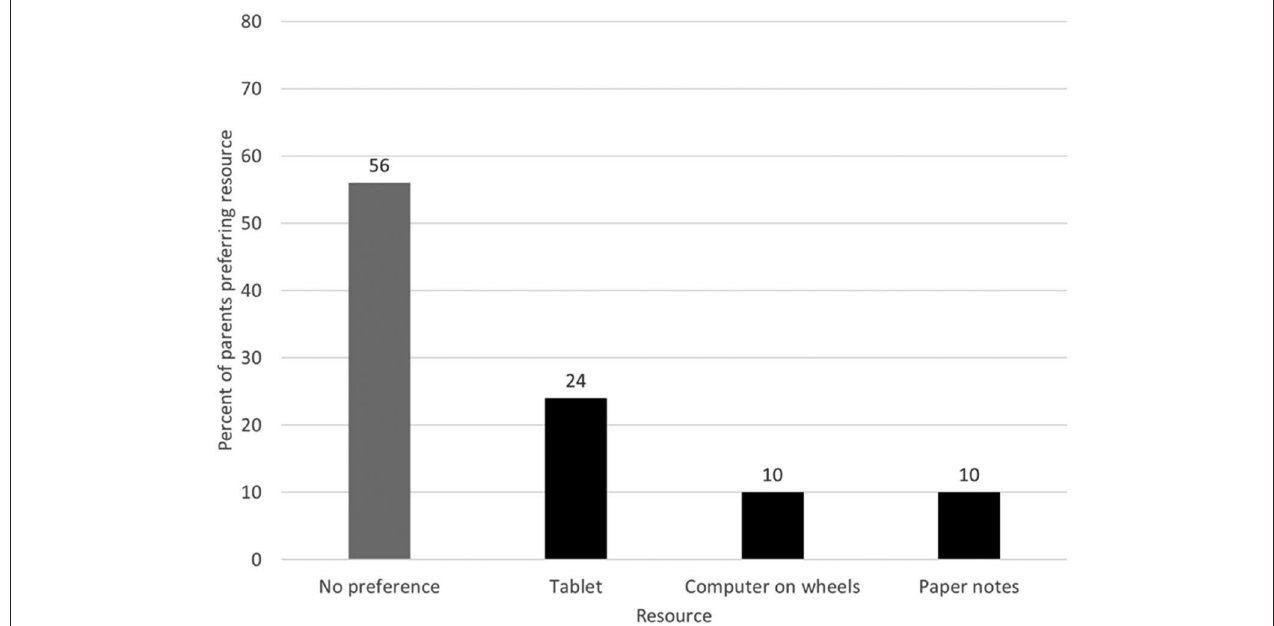
FIGURE 1 | Parent resource preferences during family-centered rounds ( n =